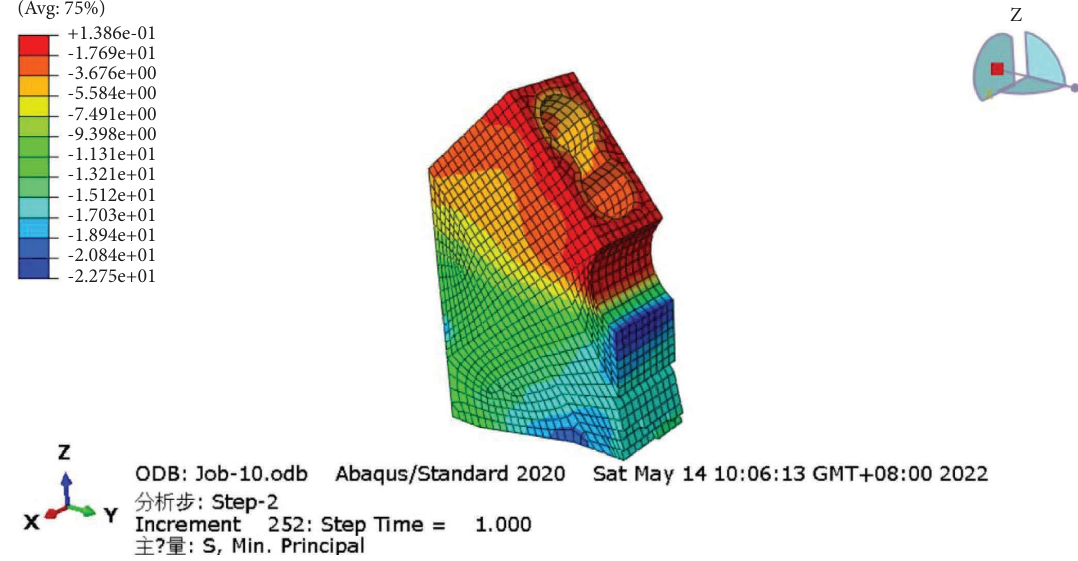
Figure 11: Cloud chart of the principal compressive stress of the arch foot without anchorage of condition 12.